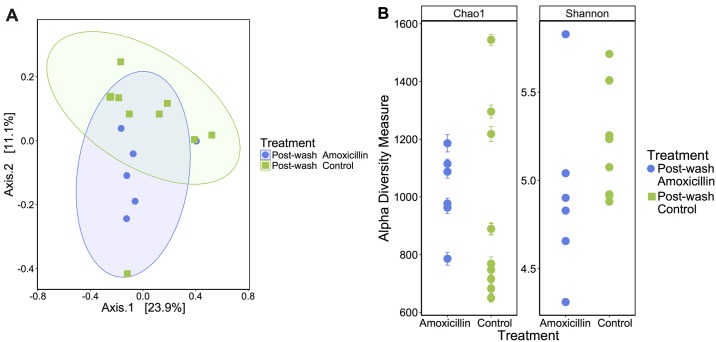
Amoxicillin treatment influenced gut-associated microbial composition, as displayed by distinct clustering in the principal coordinates plot of Bray Curtis dissimilarity on day 21 post tissue washing (A). Each dot represents fecal microbiota of one piglet (Anosim P = 0.01). Alpha diversity was not significantly reduced in piglets treated with amoxicillin on day 21 post tissue washing as indicated by Chao1 and Shannon index (P = 0.543 and P = 0.168, respectively) (B).